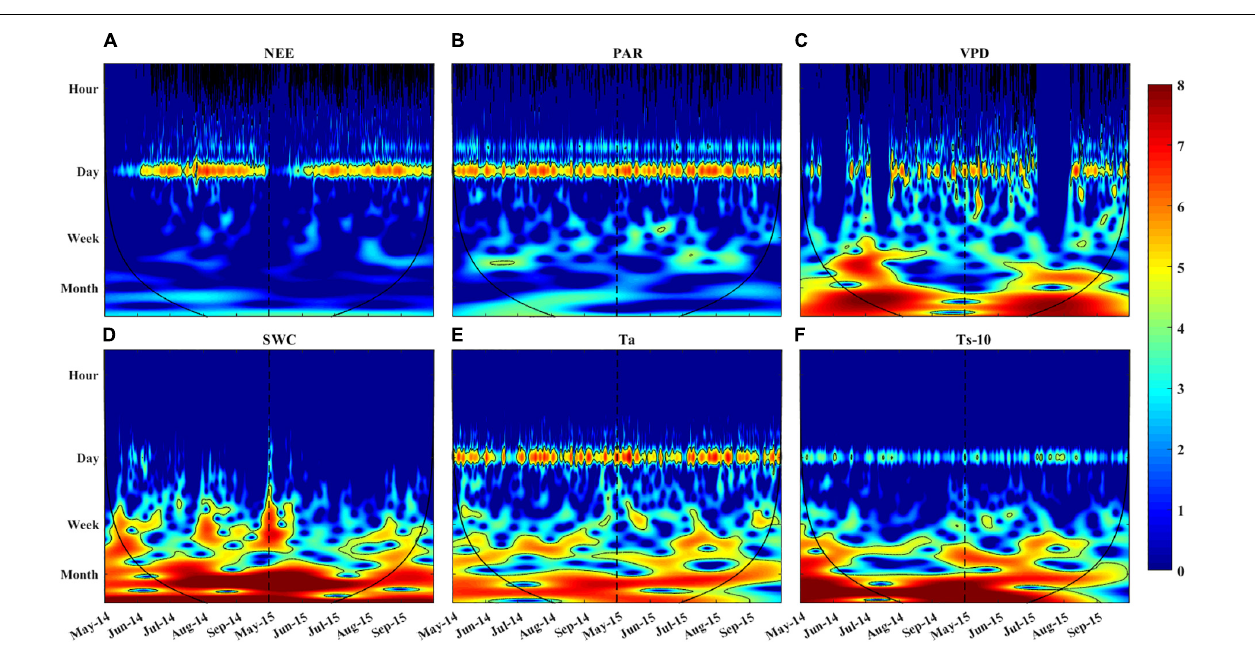
We noted that the SWC, Ta, and Ts oscillated strongly at periods between weekly to monthly as indicated in the time- frequency